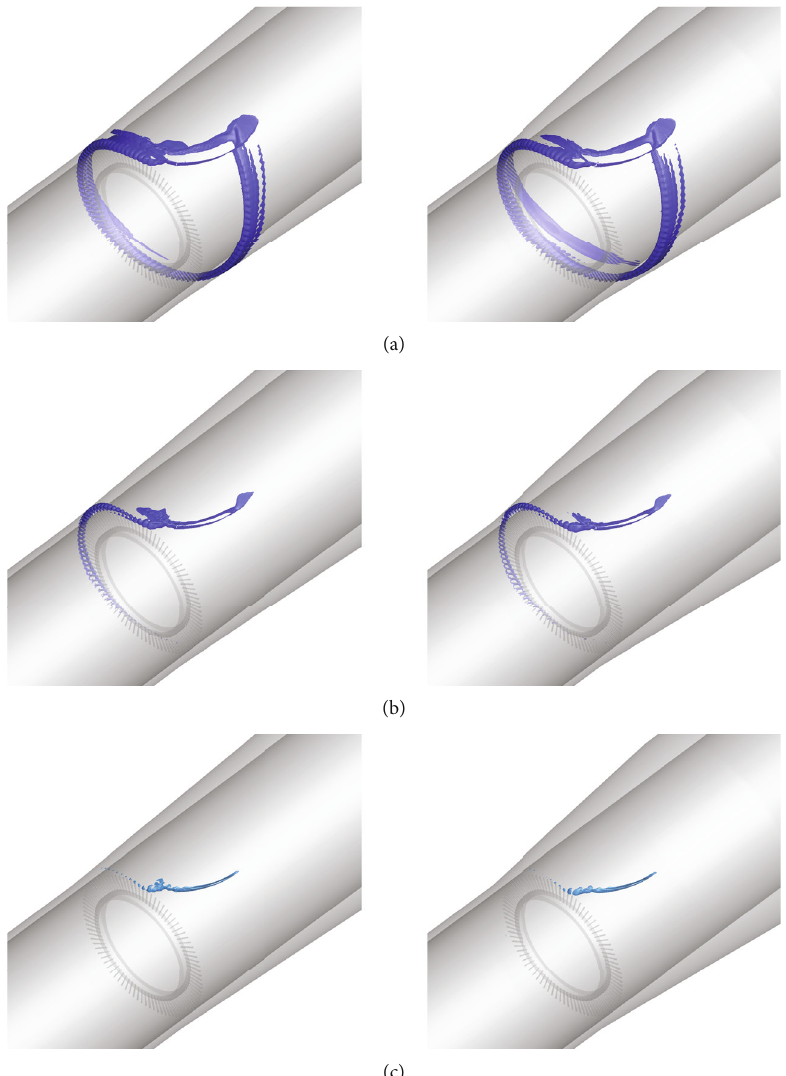
= 1 : 0 E + 10 , (b) H = 1 : 0 E + 11 , and (c) H i i